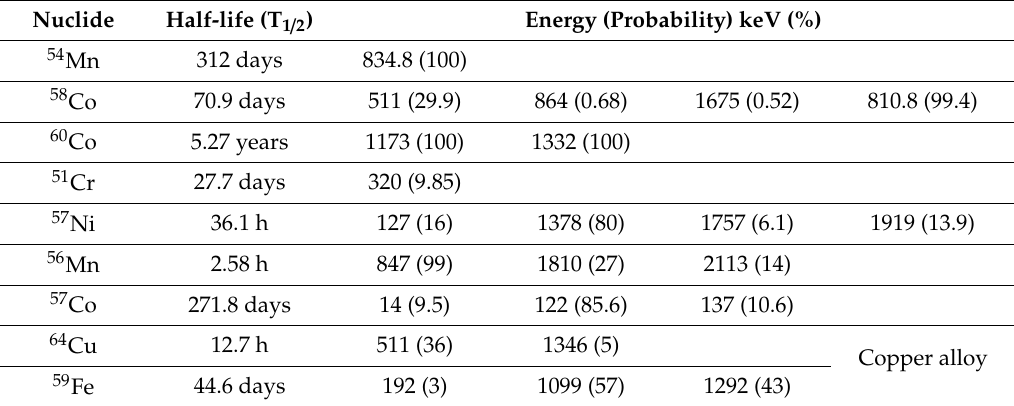
Table 1. Principal radionuclides due to the activation in solid metallic structures and their main gamma emissions